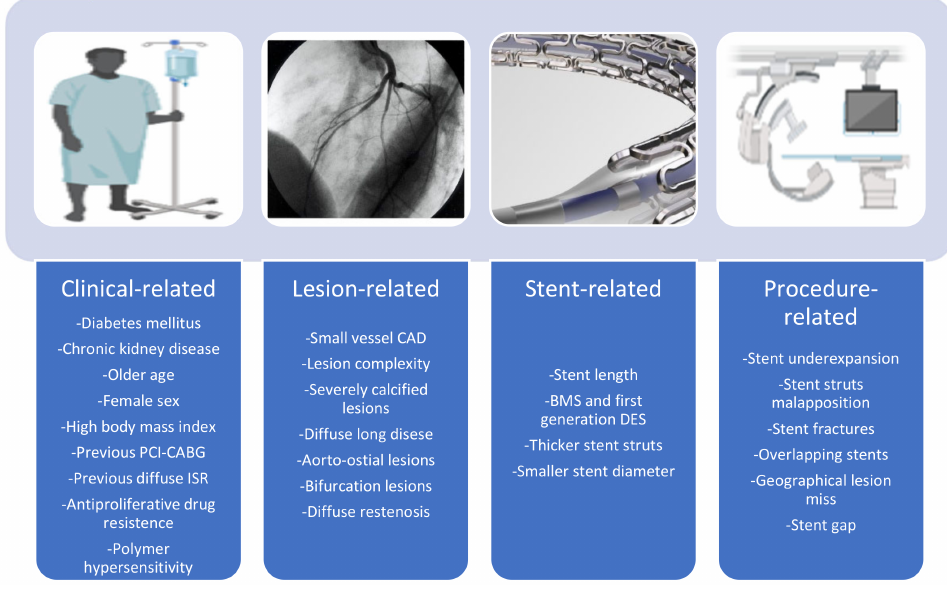
Figure 2. Overview of the main risk factors of in-stent